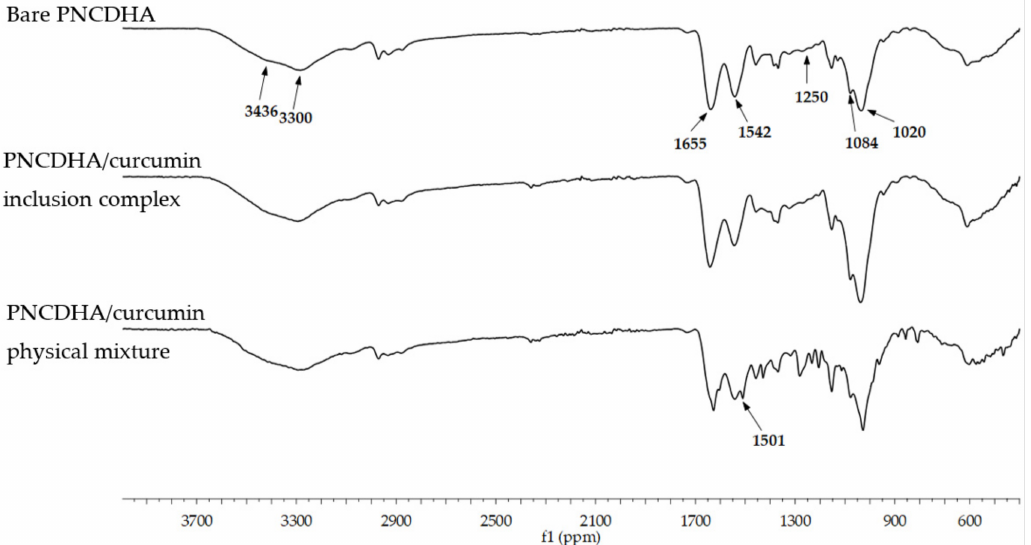
Figure 3. FTIR spectra of bare PNCDHA, inclusion complex of PNCDHA/curcumin and PNCDHA polymer physically mixed with curcumin.